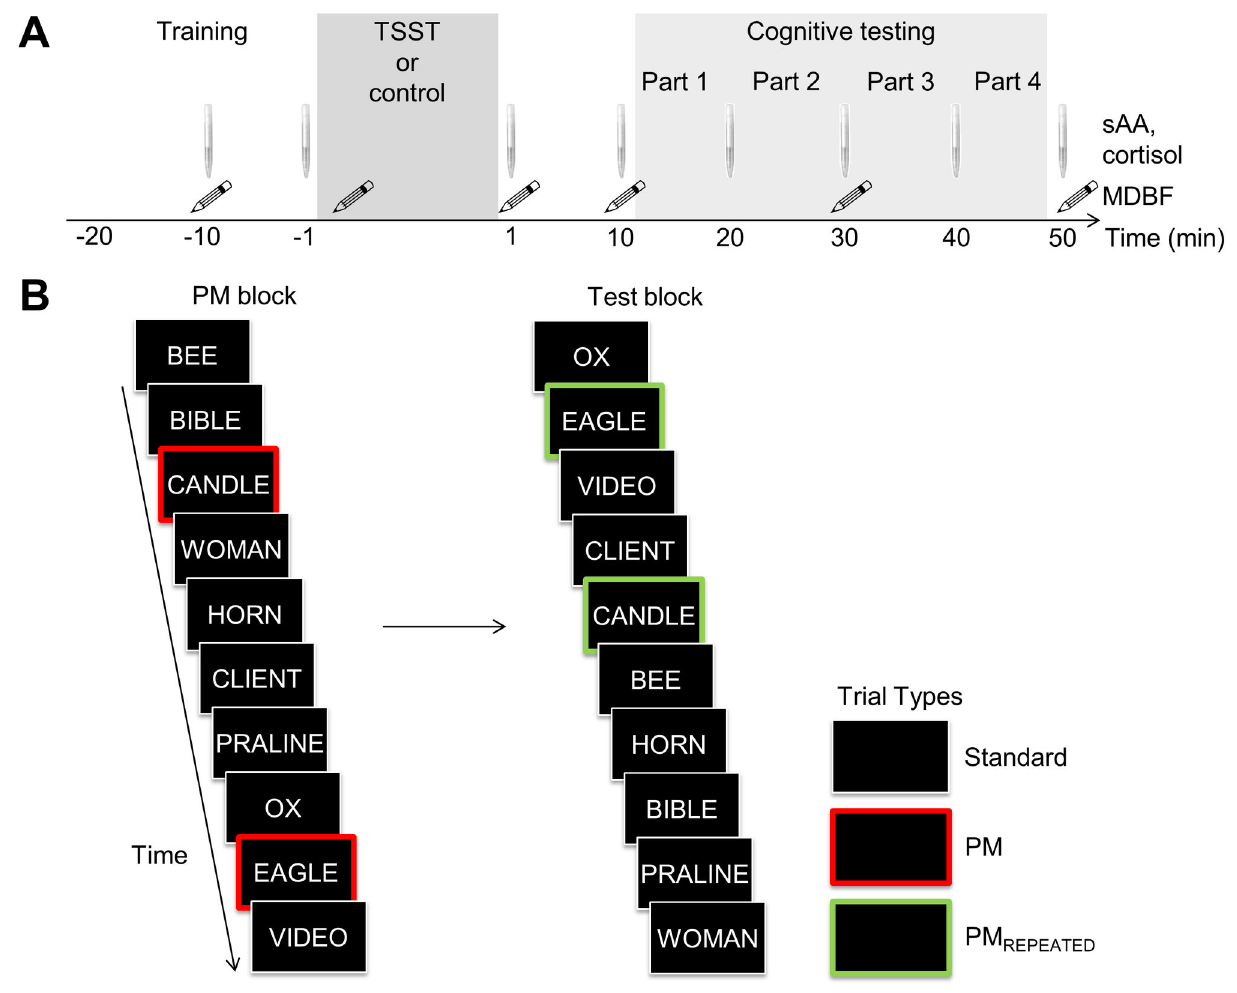
Figure 1. Procedure. (A) Schematic illustration of the procedure with the components training of the cognitive task, treatment (i.e., Trier Social Stress Test, TSST, or standardized control situation) and cognitive testing (including testing parts 1-4). Note that each part comprised two PM block-Test block cycles. In addition, measurement time-points of salivary α-amylase (sAA), cortisol and mental-state with the German “Mehrdimensionaler Befindlichkeitsfragebogen” (multidimensional mental-state questionnaire,